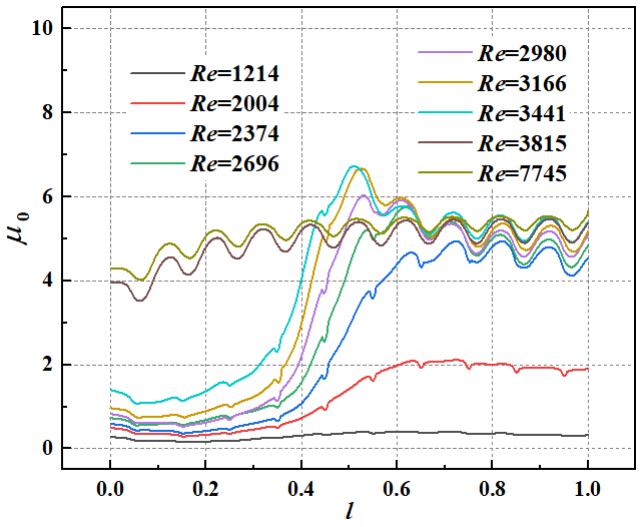
Figure 22. Eddy viscosity on the centerline of the roughened channel in the X direction.